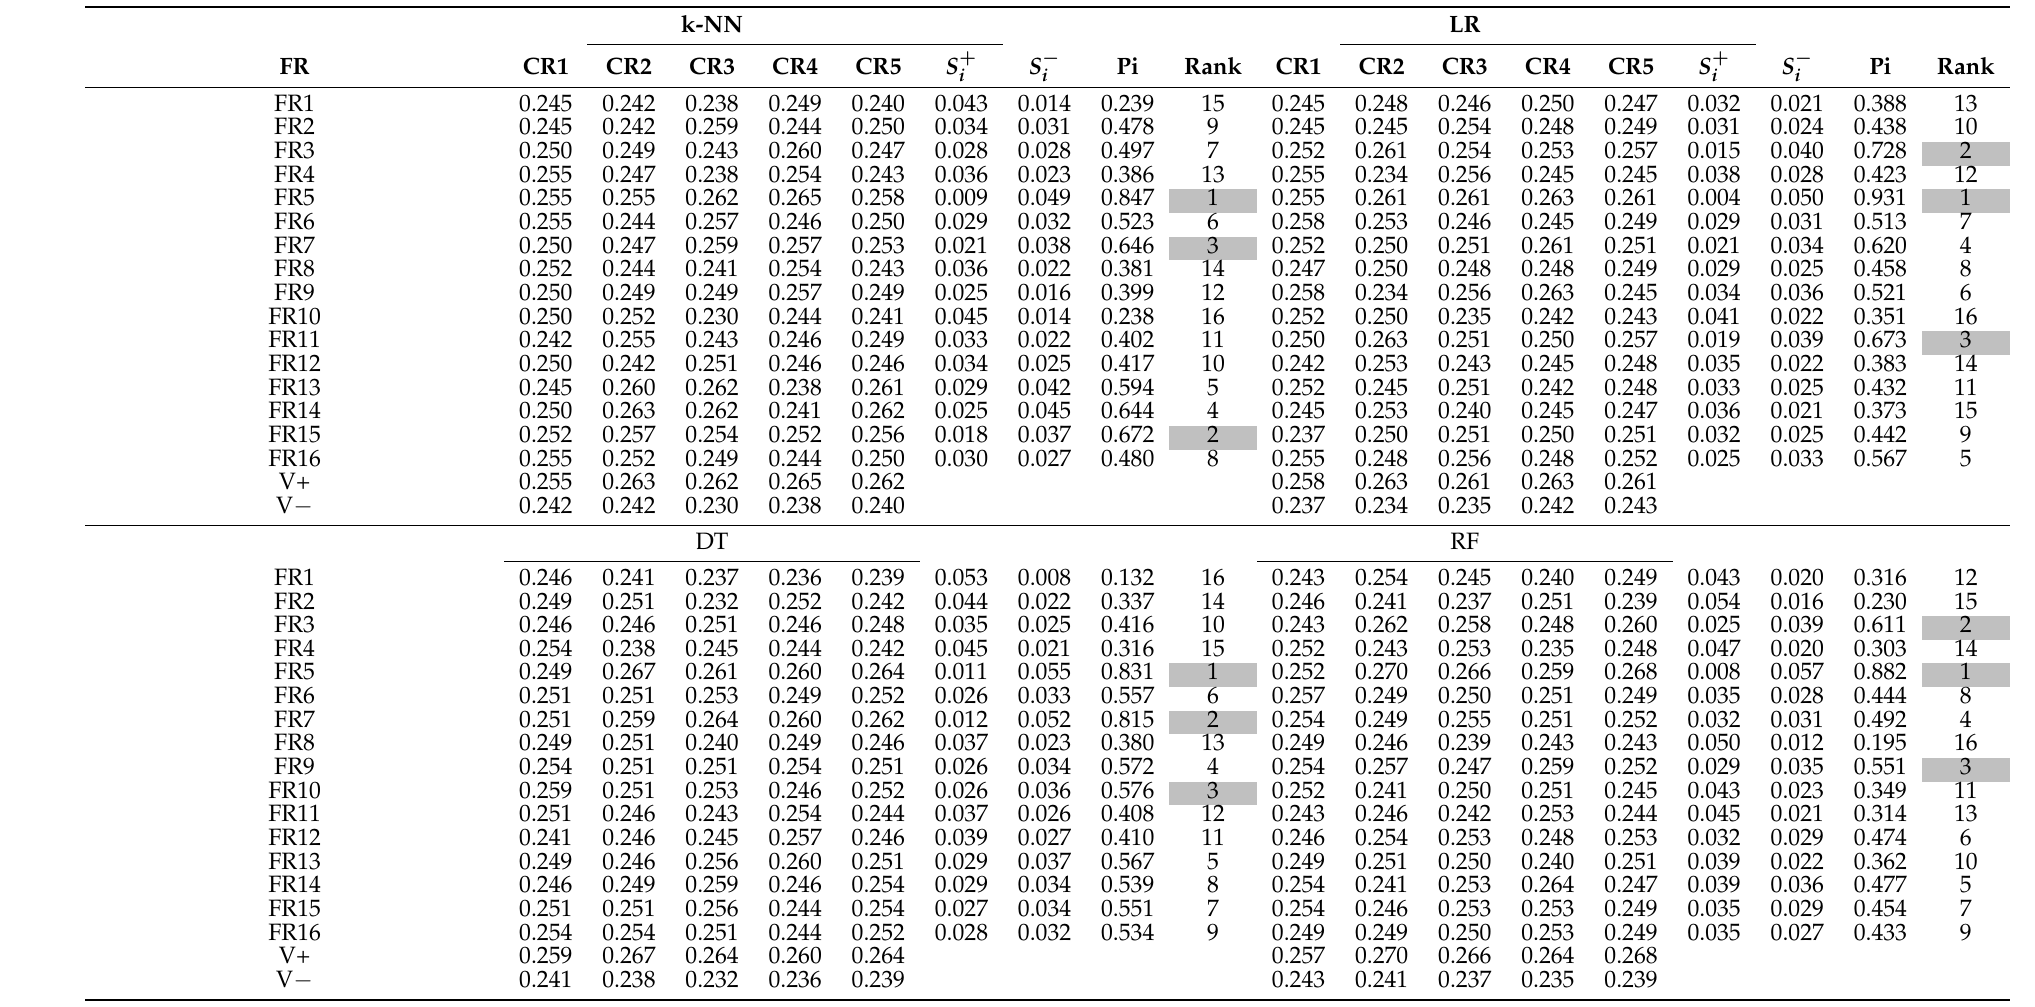
Table 8. Results of TOPSIS for Adenoma Cancer Dataset with Ranking of Feature Reduction Sequence using Dataset